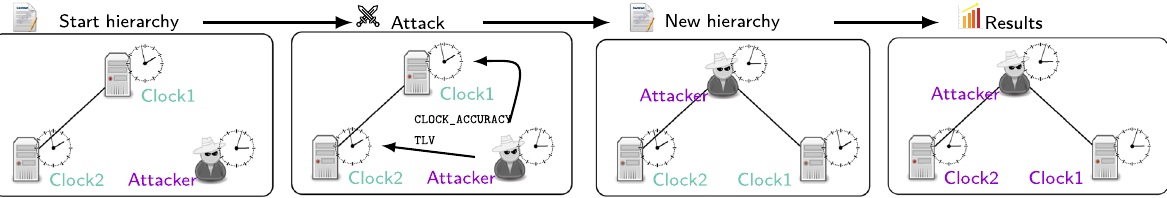
Fig. 7 Hierarchy-related attack: the attacker issue a CLOCK_ACC URA CY TLV. This TLV will poison the hierarchy management algorithm; when an election occurs, the attacker will become the Master / Grand-Master of the system. The synchronized clocks not controlled by the attacker are represented in green; the ones controlled by the attacker at every step are drawn in red